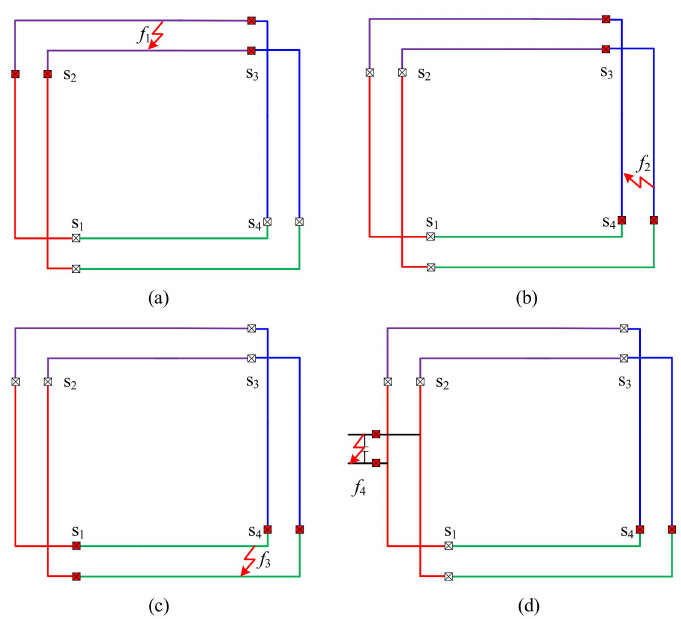
Figure 16. The protection isolation results. ( a ) f 1 faults; ( b ) f 2 faults; ( c ) f 3 faults; ( d ) f 4